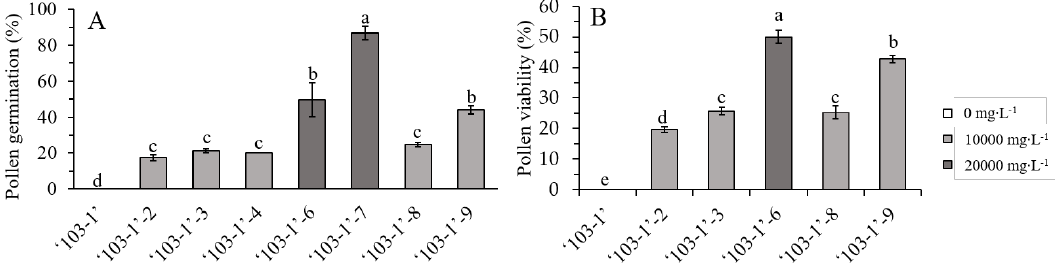
Figure 6. Percentage of pollen germination ( A ) and viability ( B ) in ‘103-1’ ( Kalanchoe garambiensis ‘Type 1’ × K. nyikae ) and colchicine-treated ‘103-1’ clones. The data represent means ± SD from three repeats (n > 100 pollens). Different letters indicate significant differences between each other at p < 0.05 using one-way ANOVA with Tukey’s HSD test.